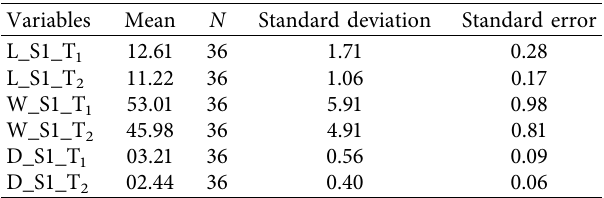
Figure 3: Design of drip irrigation in an experiment field. Table 1: Descriptive statistics for fruit length (L), weight (W), and Table 2: Descriptive statistics for fruit length (L), weight (W) and diameter (D) under IT 1 and IT 2 for season 1. diameter (D) under IT 1 and IT 2 for season